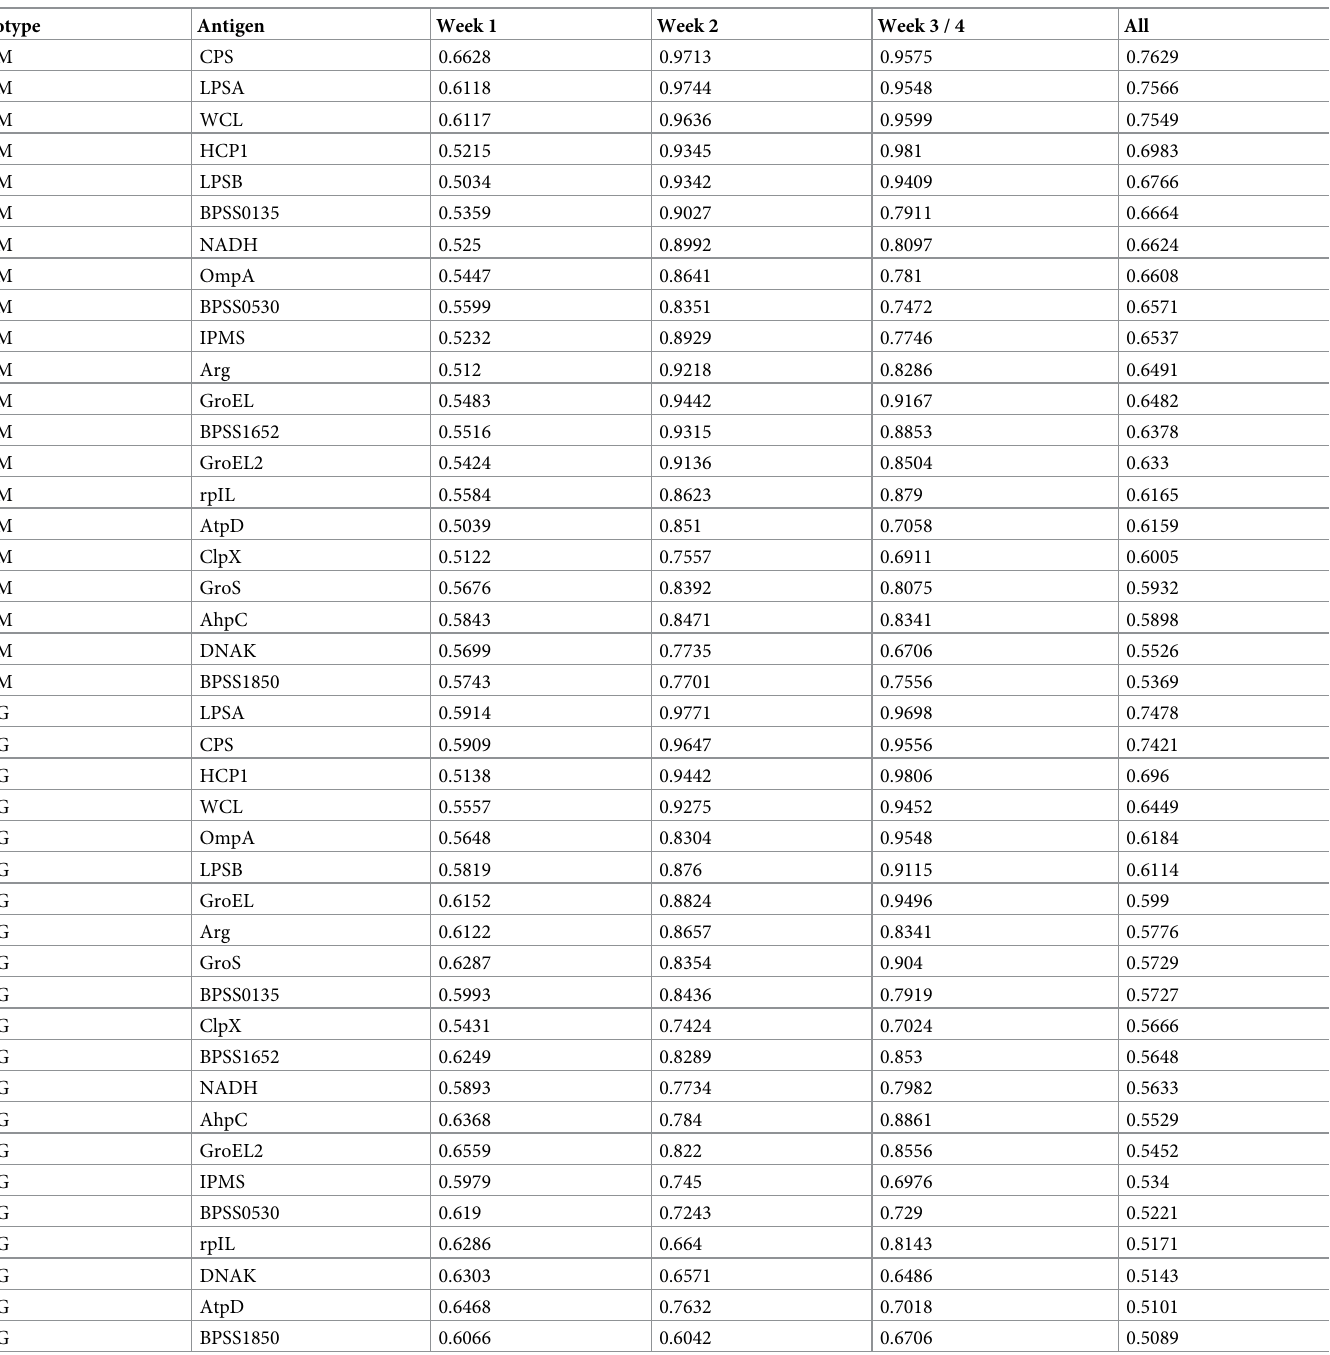
Table 2. AUC values illustrating the fit of a single antigen model for IgM and IgG BurkPx